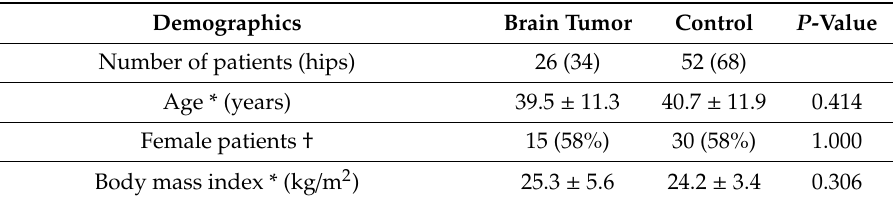
Table 3. Demographic data of the two matched